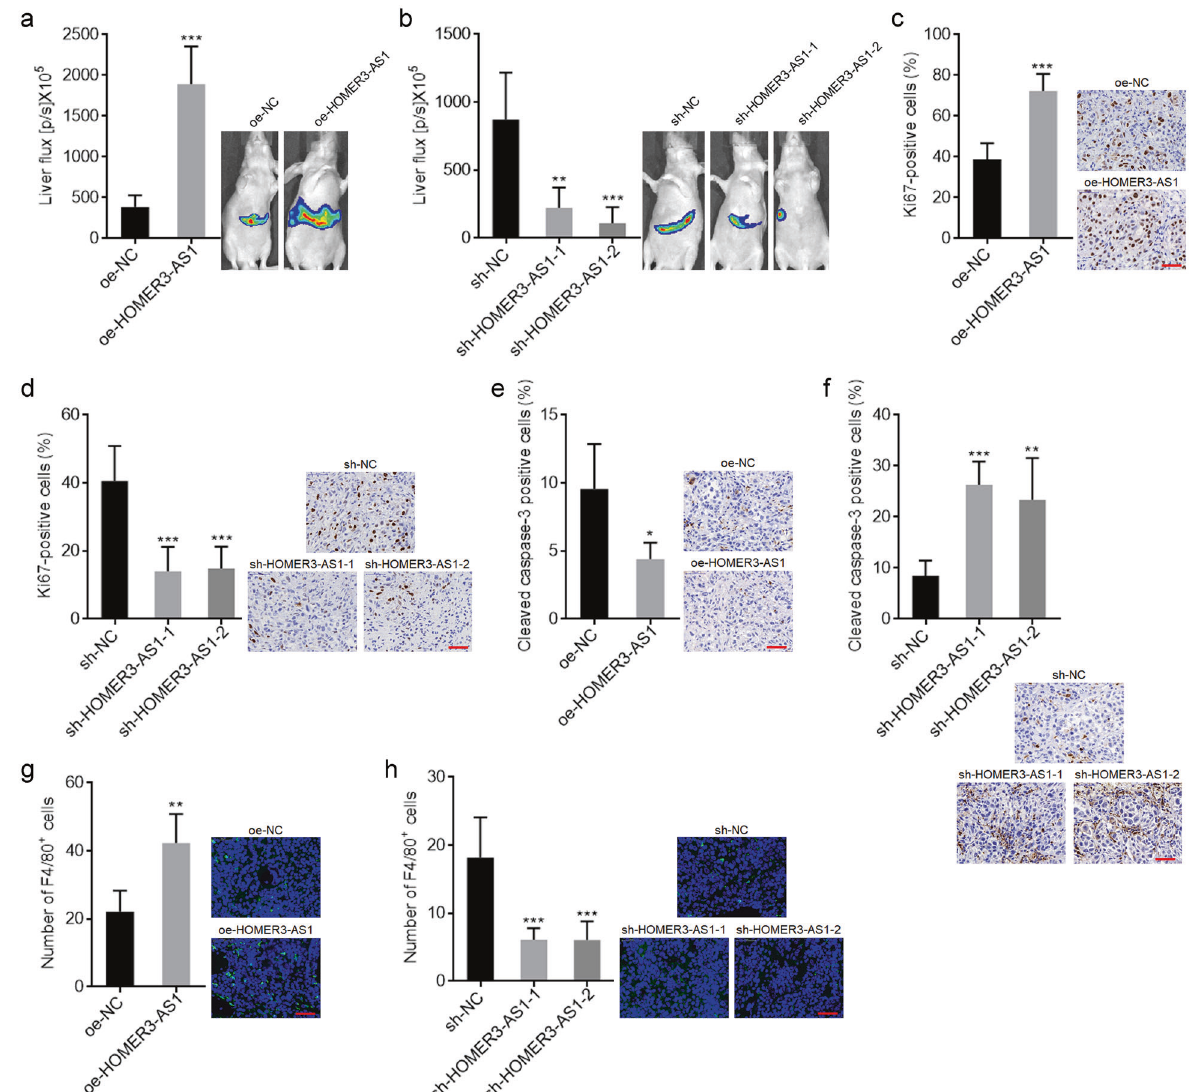
Fig. 3 HOMER3-AS1 promoted HCC tumor progression in vivo. a Bioluminescence imaging of liver tumors in mice at day 14 after inoculation with small pieces of subcutaneous tumors formed by luciferase labelled SK-HEP-1 cells with HOMER3-AS1 stable overexpression or control. b Bioluminescence imaging of liver tumors in mice at day 14 after inoculation with small pieces of subcutaneous tumors formed by luciferase labelled SK-HEP-1 cells with HOMER3-AS1 stable silencing or control. c Ki67 IHC staining of liver tumors formed by SK-HEP-1 cells with HOMER3-AS1 stable overexpression or control. Scale bars, 50 µm. d Ki67 IHC staining of liver tumors formed by SK-HEP-1 cells with HOMER3-AS1 stable silencing or control. Scale bars, 50 µm. e Cleaved caspase-3 IHC staining of liver tumors formed by SK-HEP-1 cells with HOMER3-AS1 stable overexpression or control. Scale bars, 50 µm. f Cleaved caspase-3 IHC staining of liver tumors formed by SK-HEP-1 cells with HOMER3-AS1 stable silencing or control. Scale bars, 50 µm. g F4/80 IF staining of liver tumors formed by SK-HEP-1 cells with HOMER3-AS1 stable overexpression or control. Scale bars, 50 µm. h F4/80 IF staining of liver tumors formed by SK-HEP-1 cells with HOMER3-AS1 stable silencing or control. Scale bars, 50 µm. Results are presented as mean ± SD based on n = 5 mice in each group. * p < 0.05, ** p < 0.01, *** p < 0.001 by Student ’ s t -test ( a , c , e , g ) or one-way ANOVA followed by Dunnett ’ s multiple comparisons test ( b , d , f , h ).